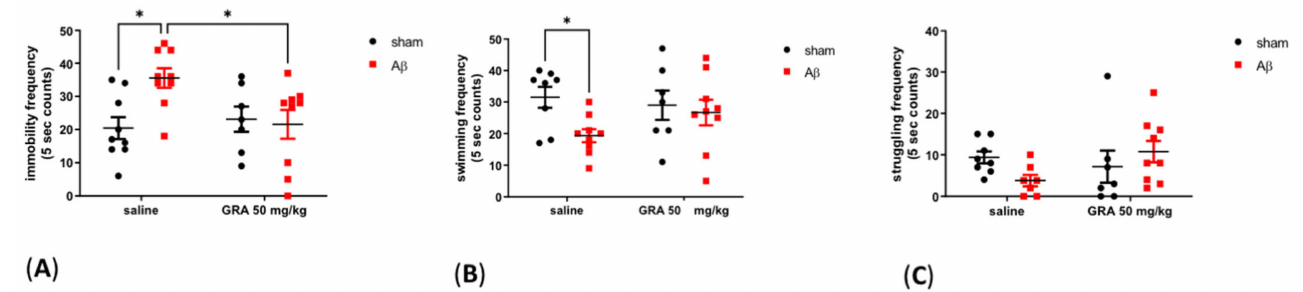
Figure 3. Effect of GRA administration in the FST in sA β -1-42-treated rats. Effect of GRA (50 mg/kg) administration on immobility ( A ), swimming ( B ) and struggling ( C ) frequencies (saline sham n = 9, saline sA β 1-42 n = 9, GRA sham n = 7 and GRA sA β 1-42 n = 9) in the FST in rats 7 days after i.c.v. injection of vehicle (sham, 5 µ L, black dots) or A β (A β , 4 µ M, red dots). * p < 0.05 saline sA β 1-42 vs. saline sham; * p < 0.05 GRA sA β 1-42 vs. saline sA β 1-42. Two-way ANOVA followed by Bonferroni’s post hoc test.